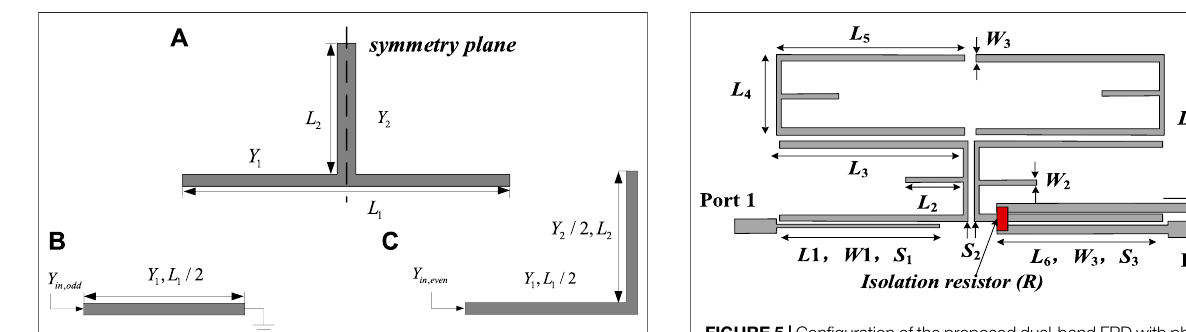
FIGURE 5 | Con fi guration of the proposed dual-band FPD with physical dimensions: L 1 = 16.5, L 2 = 8.5, L 3 = 17, L 4 = 7.65, L 5 = 17.9, L 6 = 16.3, and L 7 =24, W 1 =0.36, W 2 =0.3,and W 3 =1.1, S 1 =0.1, S 2 =0.3,and S 3 =0.1(all units: mm), and R = 195 Ω . The design targets of the proposed dual- band FPD are given as follows: 1) Passbands 1: 1.87 – 1.92 GHz; 2) Passbands 2: 2.06 – 2.11 GHz; 3) Return loss: 20 dB; 4) Isolation: > 20 dB; 5) Phase distribution: 90 °